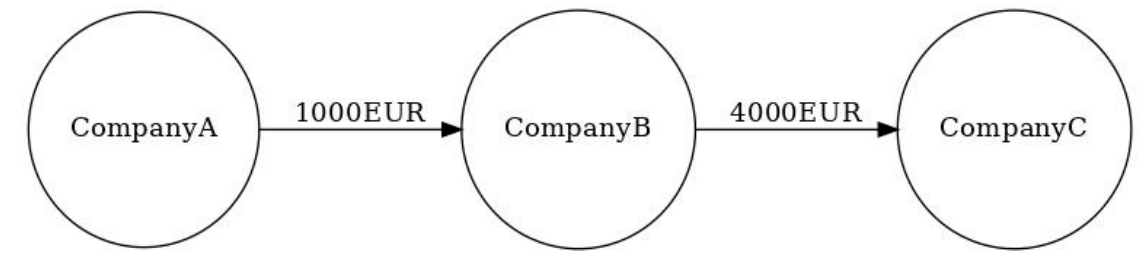
Figure 2. Debt relation among three companies after cancelation.